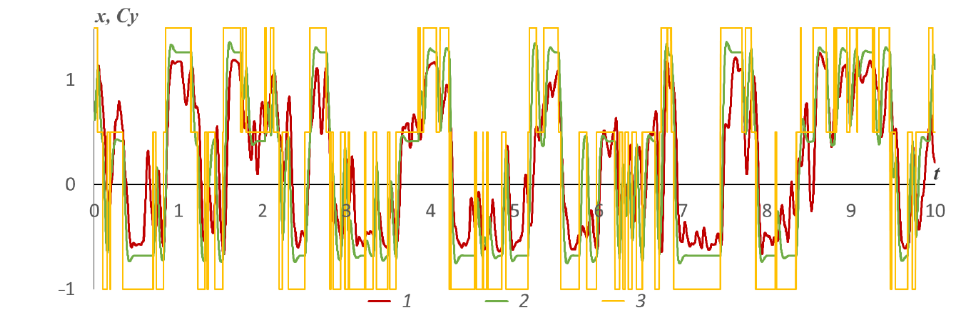
1 2 ; 2—system t i